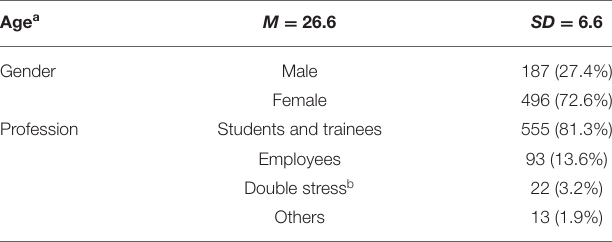
TABLE 1 | Basic characteristics of the survey participants ( n = 683). Age a M = 26.6 SD = 6.6 Gender Male 187 (27.4%) Female 496 (72.6%) Profession Students and trainees 555 (81.3%) Employees 93 (13.6%) Double stress b 22 (3.2%) Others 13 (1.9%) Mean (M) and standard deviation (SD), or number and percentage of participants are